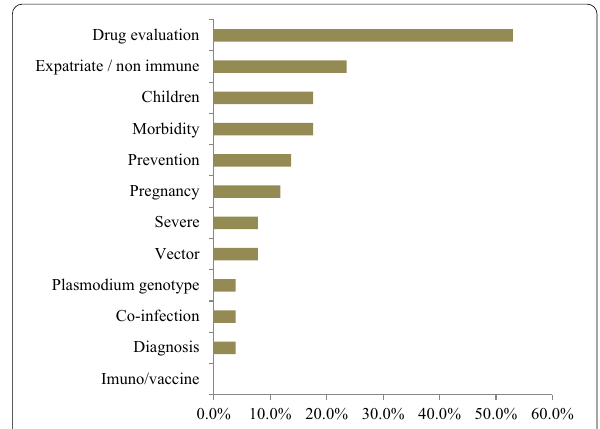
Fig. 3 Areas of focus for malaria research in Central African